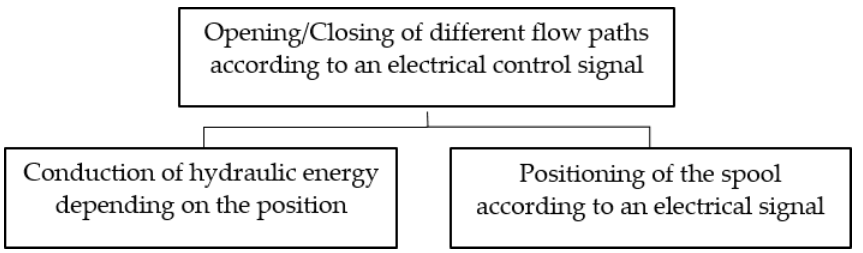
Figure 1. The structure of the general function.